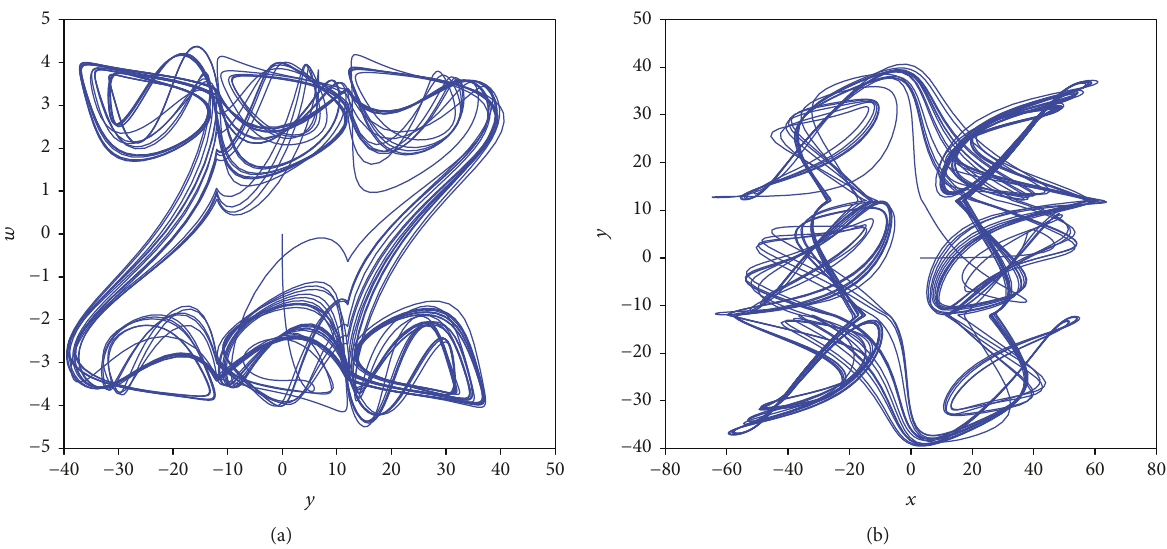
Figure 5: Projections of the 2 × 3 multiscroll hyperchaotic attractors onto the y , w and x , y plane. (a) y , w plane. (b) x , y